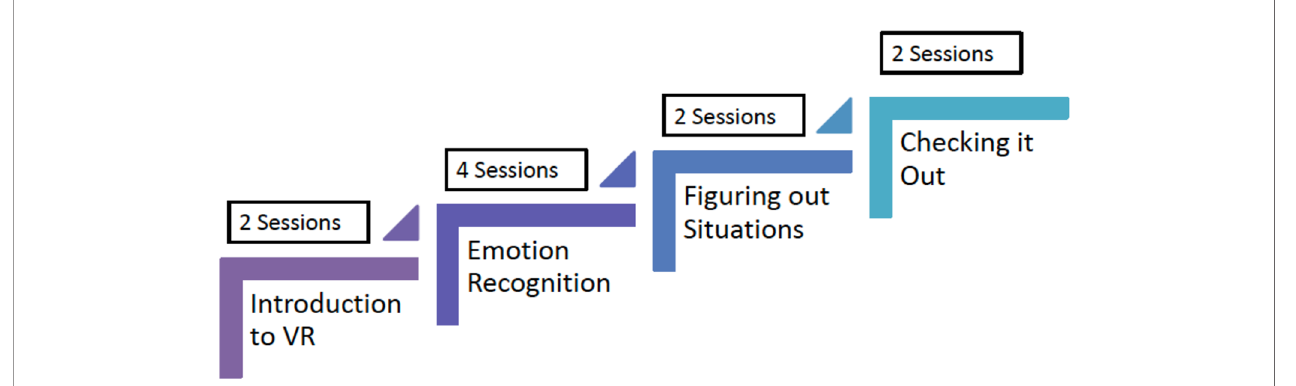
FIGURE 2 | SCIT-VR